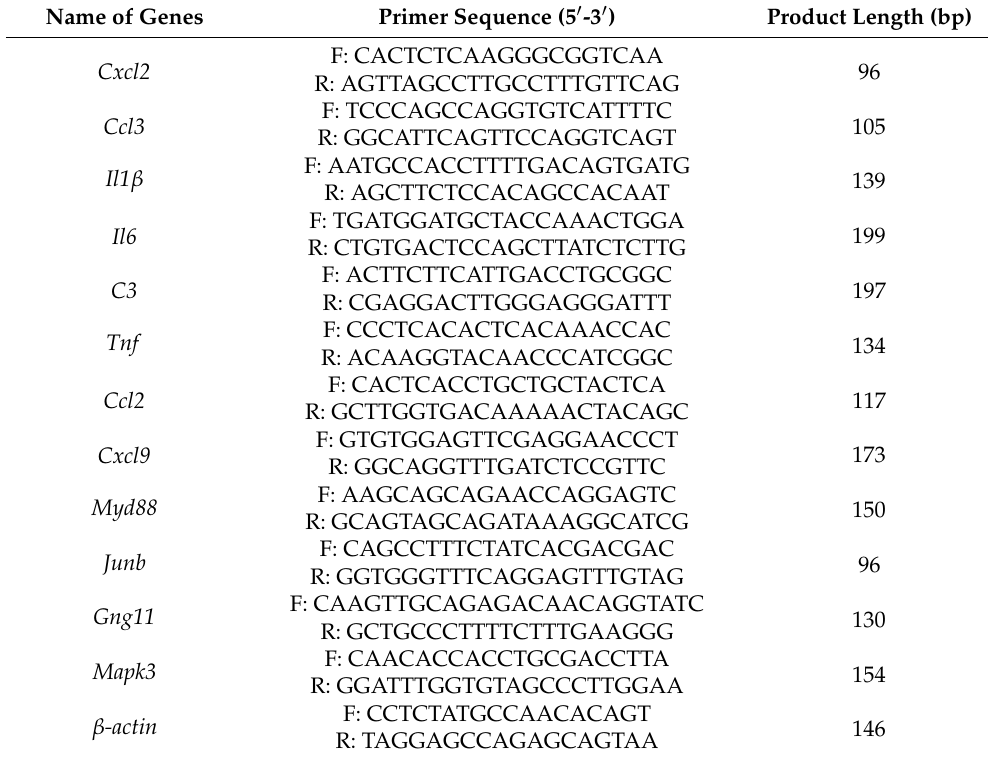
Table 1. Information of genes and corresponding